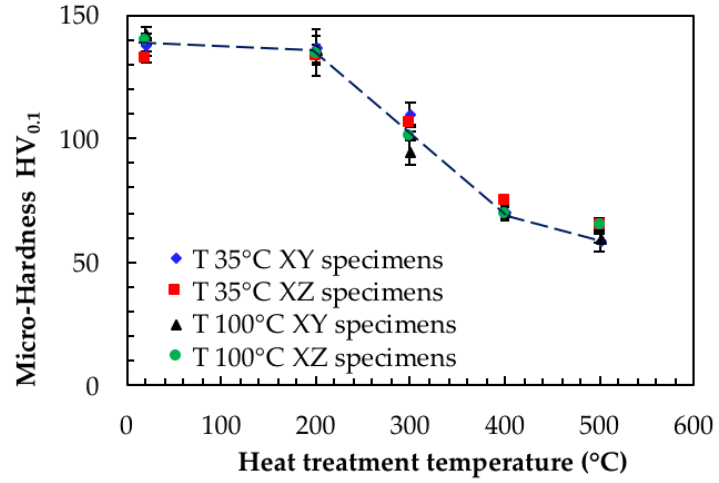
Figure 11. Effect of thermal treatments on microhardness. Table 3. Results of microhardness measurements (HV 0.1 ).